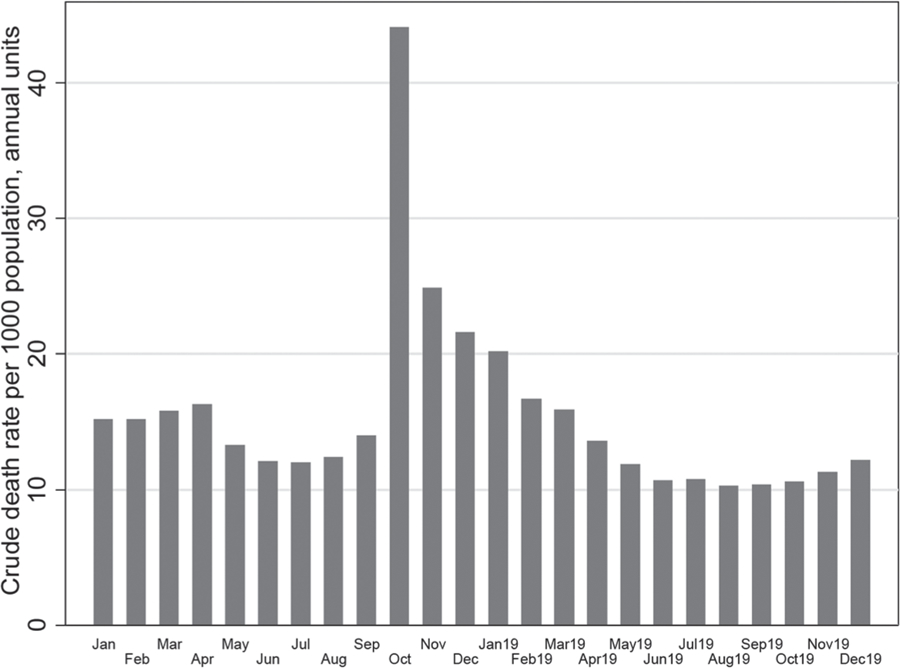
Crude death rates by month (per 1000 population) in the United States in 1918–1919. Rates computed on an annual basis. Source: authors’ estimations based on (Bureau of the Census 1943)